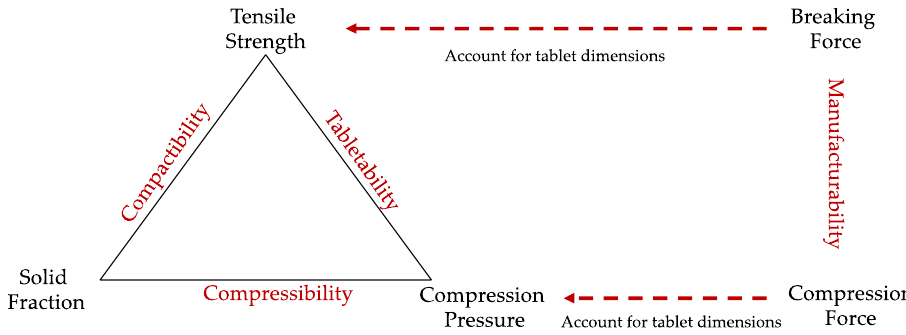
10 of 27 Table 4. Mixture design and ternary plot for ITZ ASD tablets formulations. Component (%) Formulation No. Ternary Diagram 1